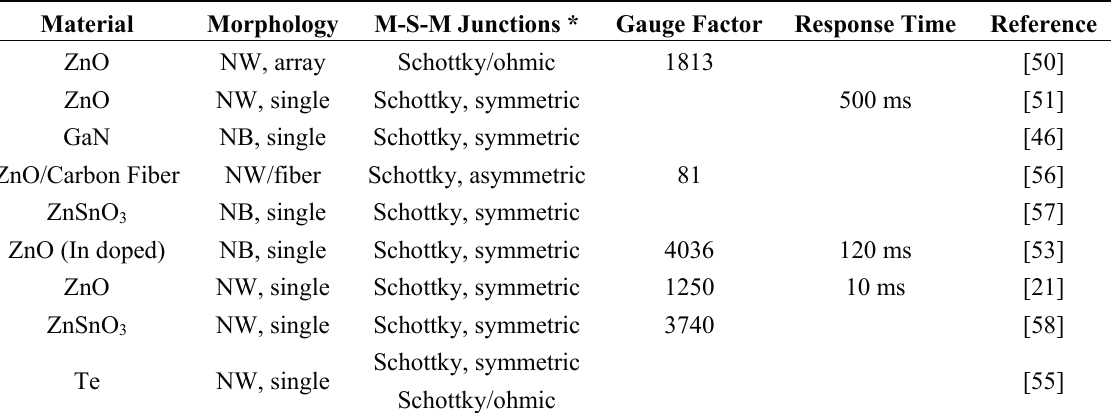
Table 1. A comparison of strain sensing